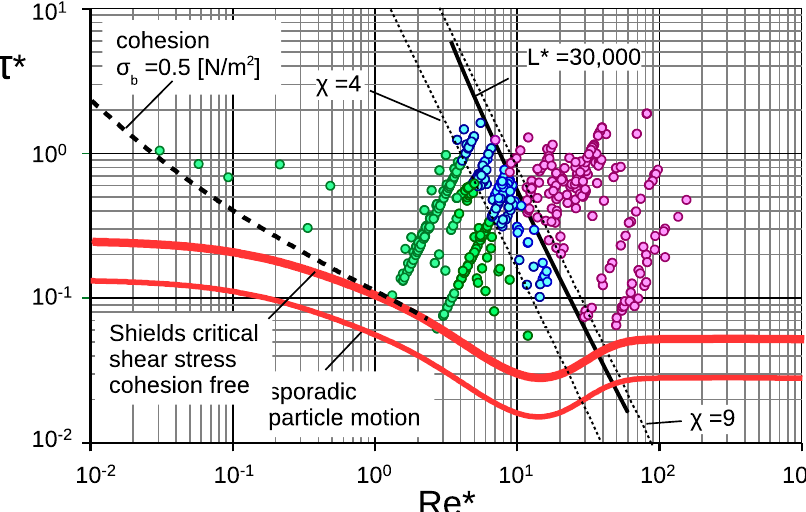
Figure 12. Representation of the domain boundaries in the τ (cid:63) − Re (cid:63) -plane. Ripples exist in the green and blue areas. In the green area the ripples are dominated by the Reynolds number v (cid:63) d / ν and are modulated by the degree of suspension concentration. The area marked blue is dominated by the effect of boundary layer acceleration. For data source, see Section